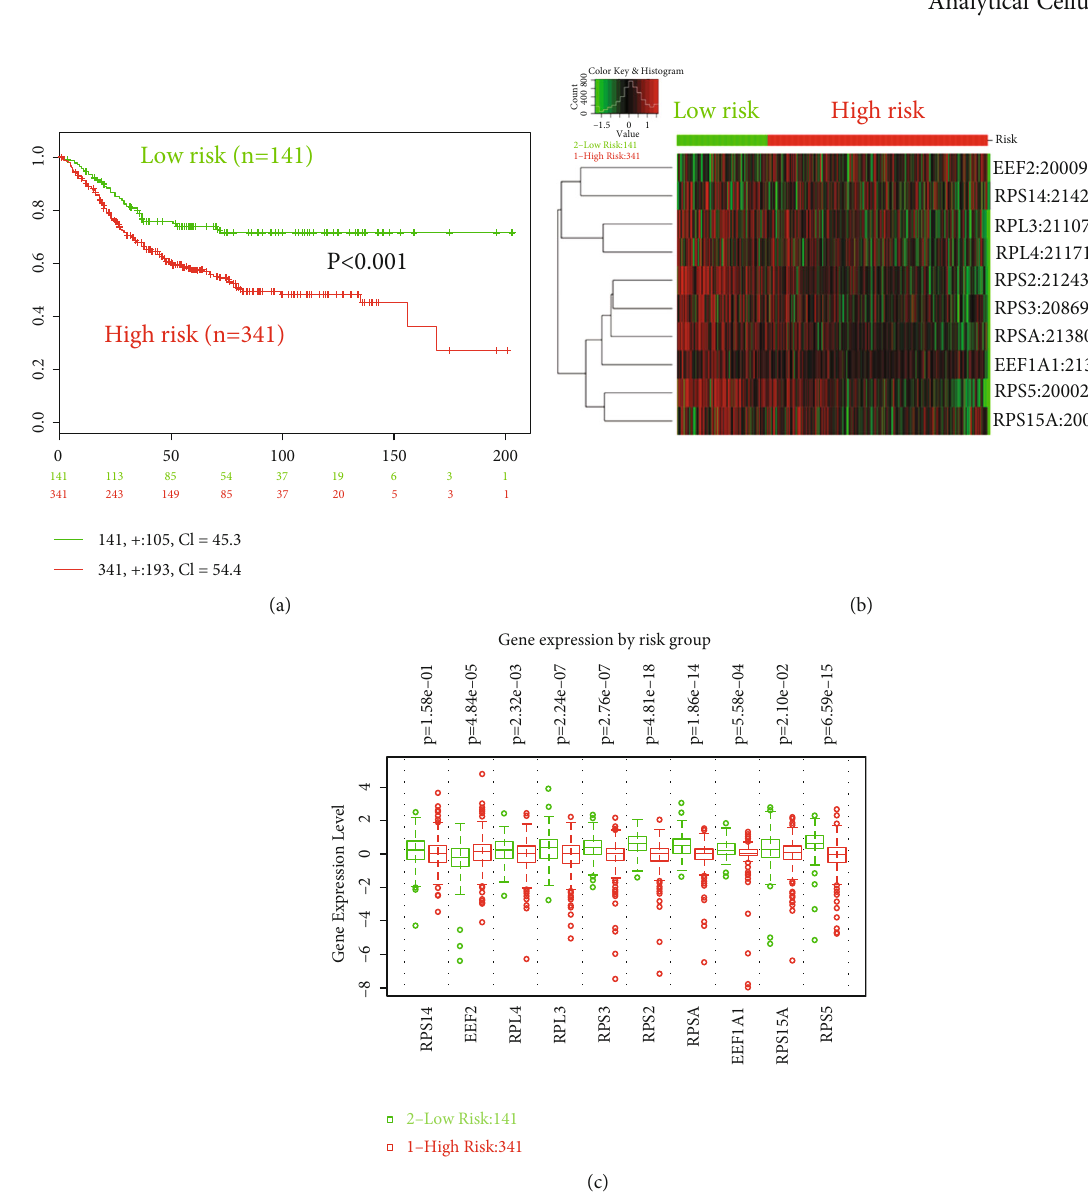
Figure 8: The prognostic values (overall survival, OS) of hub gene signature in colorectal cancer via the SurvExpress platform. (a) The KM plot of high-/low-risk groups divided by prognostic index; (b) the mRNA expression of high-/low-risk OS groups in heat map; (c) the mRNA expression comparison between high- and low-risk OS groups. High risk: red; low risk: